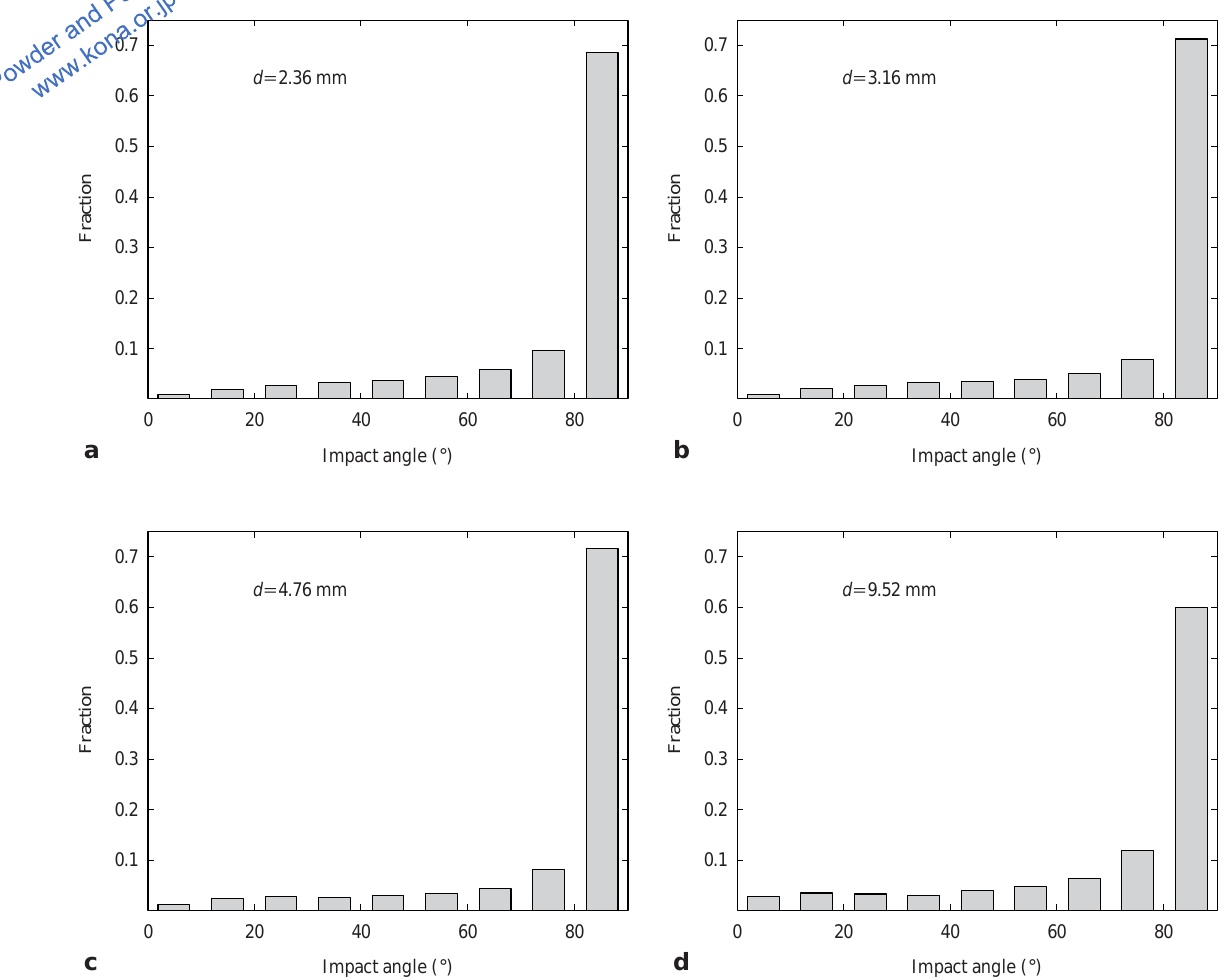
Distribution of the fraction of energy dissipation per impact as a function of the collision angle for the systems with different ball sizes: a. d (cid:3) 2.36 mm; b. d (cid:3) 3.16 mm; c. d (cid:3) 4.76 mm, and d. d (cid:3) 9.52 mm.